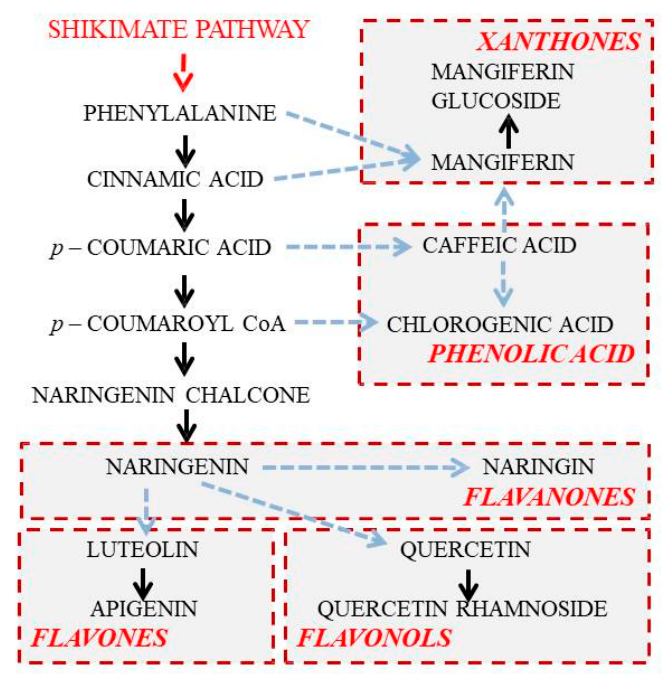
Figure 3. Proposed biosynthetic routes leading to phenolic compounds found in I. variegata leaves within the present study.